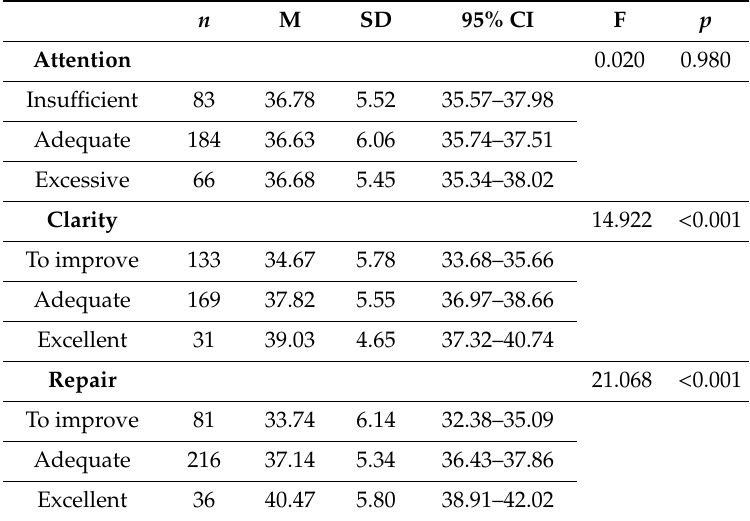
Table 5. Comparison of emotional well-being means based on the emotional Attention, Clarity, and Repair